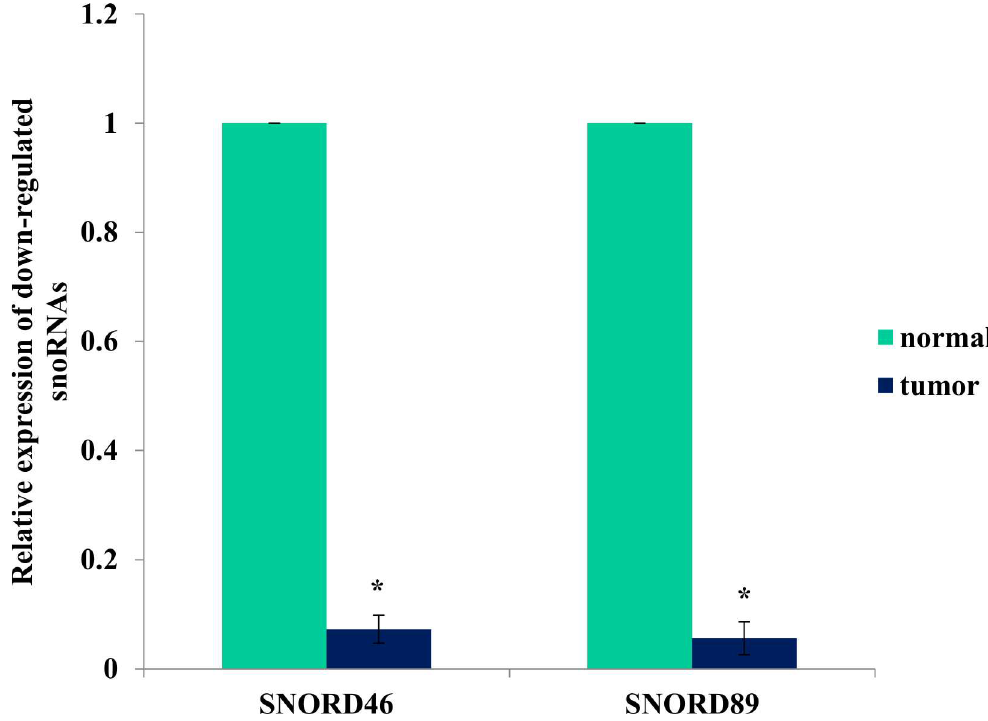
Fig 3. qRT-PCR confirmationof snoRNAexpression. SNORD46 and SNORD89 were confirmed to be down– regulated in tumor, relative to normalsamplesusing qRT-PCR platform.The Ct values obtainedfor snoRNAs were normalizedto Ct values obtainedfor RNU6. * indicatesstatisticalsignificance p < 0.05.